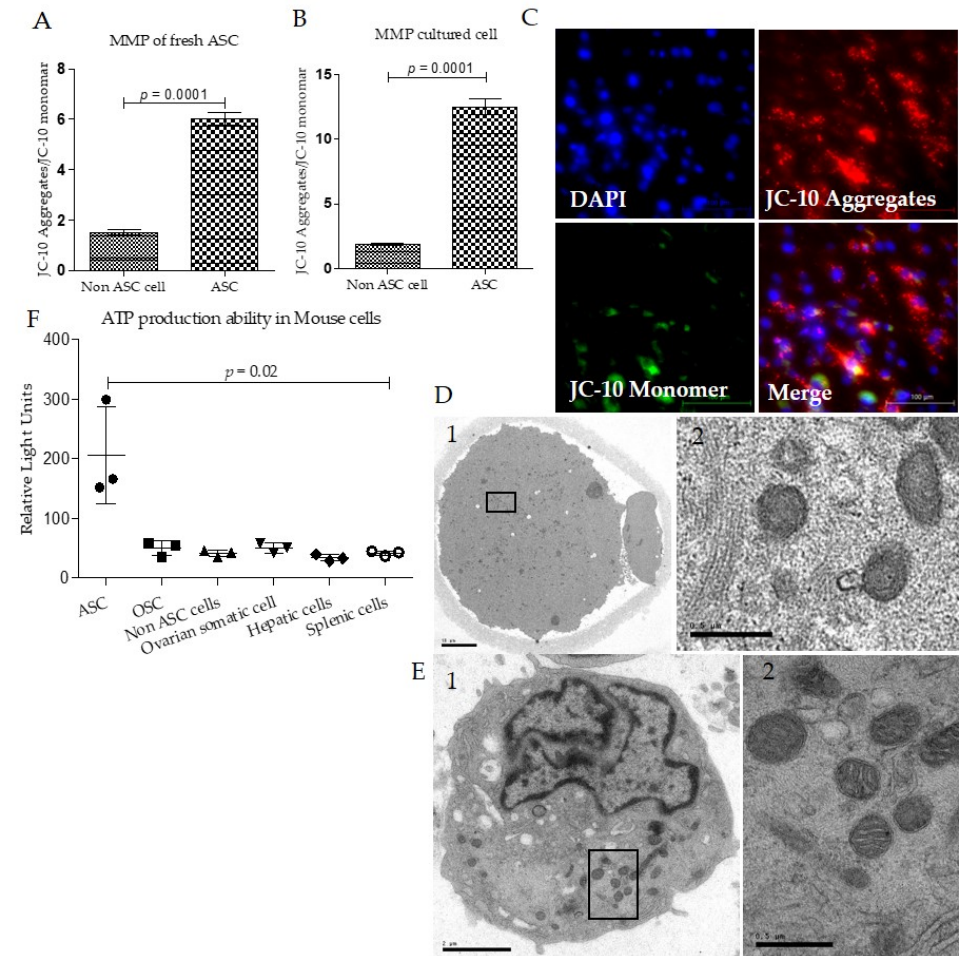
Figure 3. Mitochondrial characteristics of mouse adipose stem cells (ASC)and mature oocytes. ( A ). The ASC and non-ASC were sorted from the single-cell fraction isolated from adipose tissues. Additionally, mitochondrial membrane potential (MMP) was analyzed through staining with JC-10 and using FACS. ( B ). The cultured ASC (at passage 3) was analyzed for MMP, and both fresh and cultured ASCs show higher MMP than non-ASC cells. ( C ). The representative fluorescence micrographs show the JC-10-stained cultured ASC ( D ). Representative transmission electron micrograph (TEM) of mature mouse oocyte (scale bar—10 μ m) and higher magnification of oocyte mitochondria (scale bar—0.5 μ m). ( E ). Representative transmission electron micrograph of ASC (scale bar—2 μ m) higher magnification of ASC mitochondria (scale bar—0.5 μ m) show spherical shape mitochondria. ( F ). The ATP production ability (RLU, relative light unit) is significantly higher in ASC compared with different cell types such as ovarian stem cell (OSC), non-ASC cells, ovarian somatic cells, hepatic cells, and splenic cells. Data in the graphs are represented as mean ± SD.